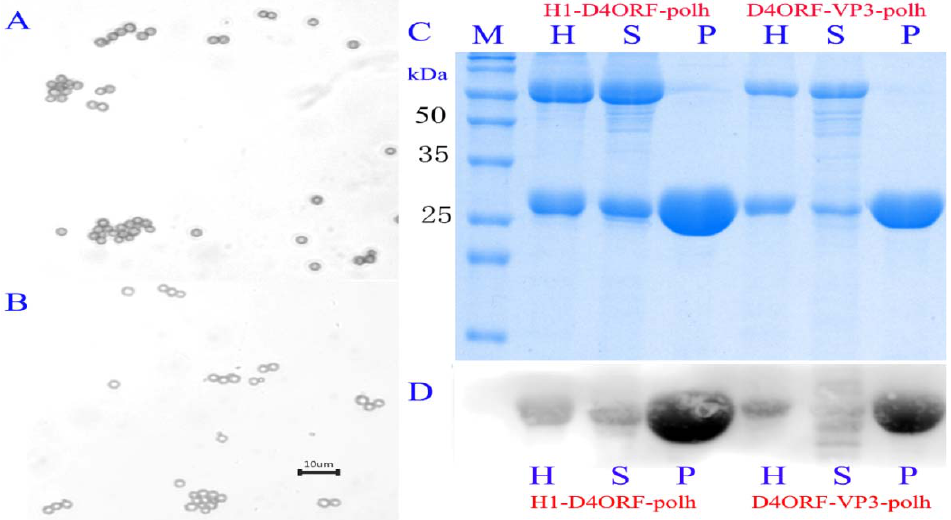
Figure 3. H1-D4ORF and D4ORF-VP3 recombinant proteins can be incorporated into BmCPV